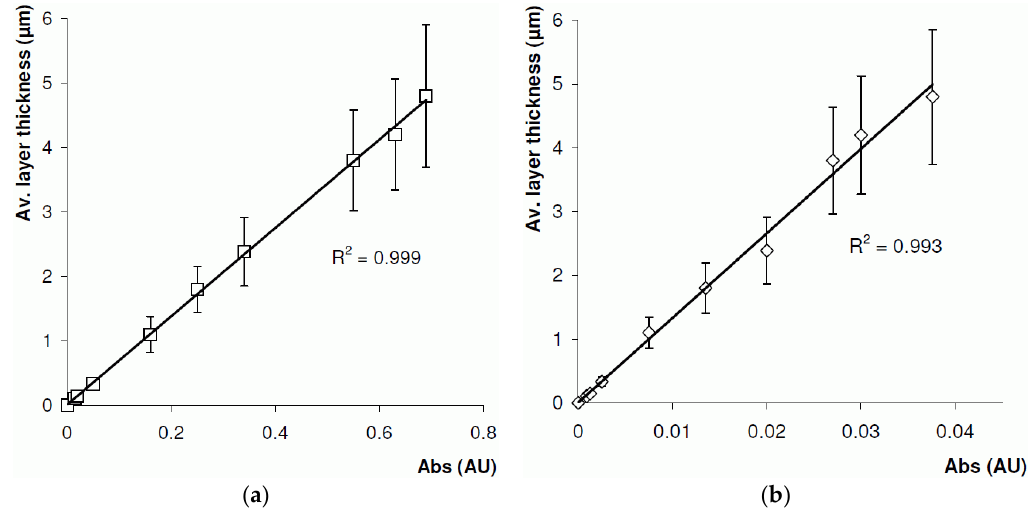
Figure 6. Relationship between monolithic porous layer open tubular column layer thickness and optical absorbance at 700 nm for BuMA -co- EDMA layer formed inside a 100 µm ID polyimide-coated fused silica capillary using ( a ) 100 µm and ( b ) 8 µm optical fibre.